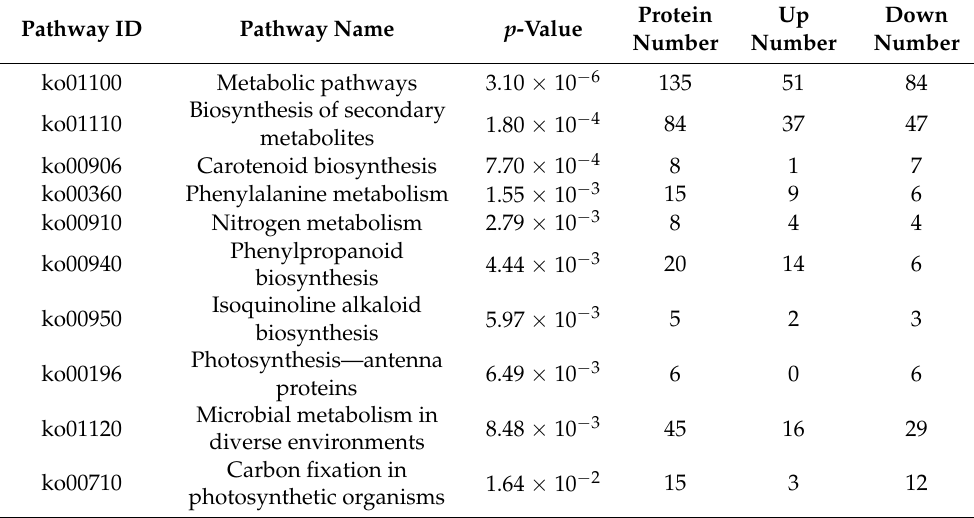
Table 3. KEGG pathway enrichment analysis of DEPs in seashore